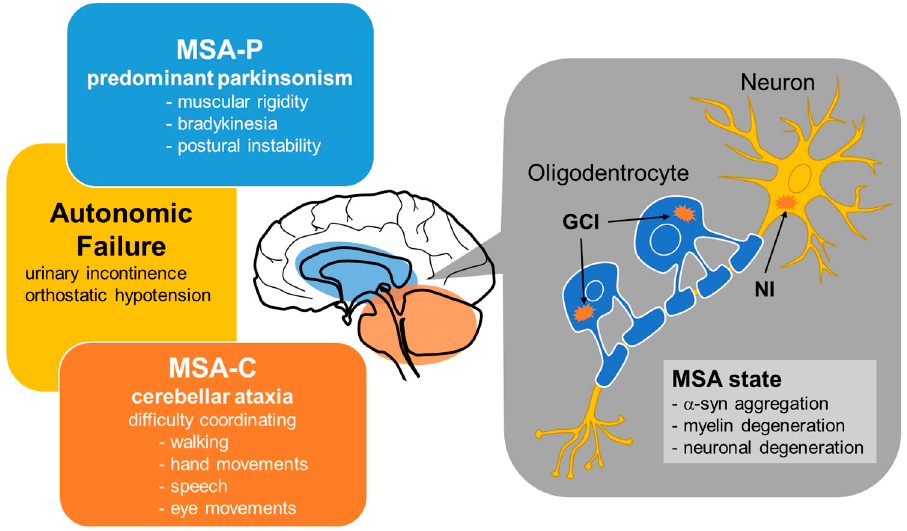
Figure 1. Clinical and pathological features of